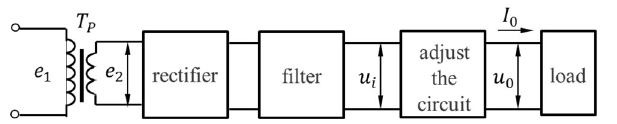
Figure 17. Capacitor filtering flowchart.